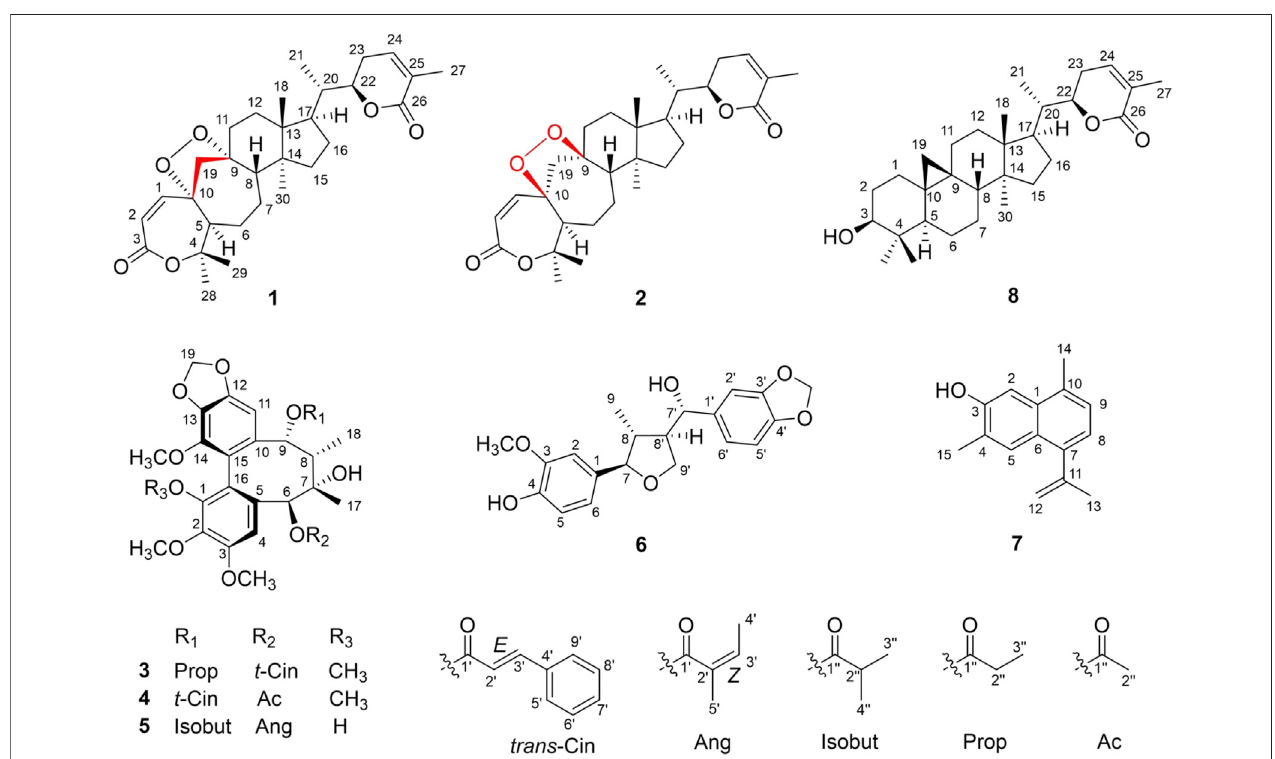
FIGURE 1 | Structures of new compounds (1 – 7) and a natural product (8)